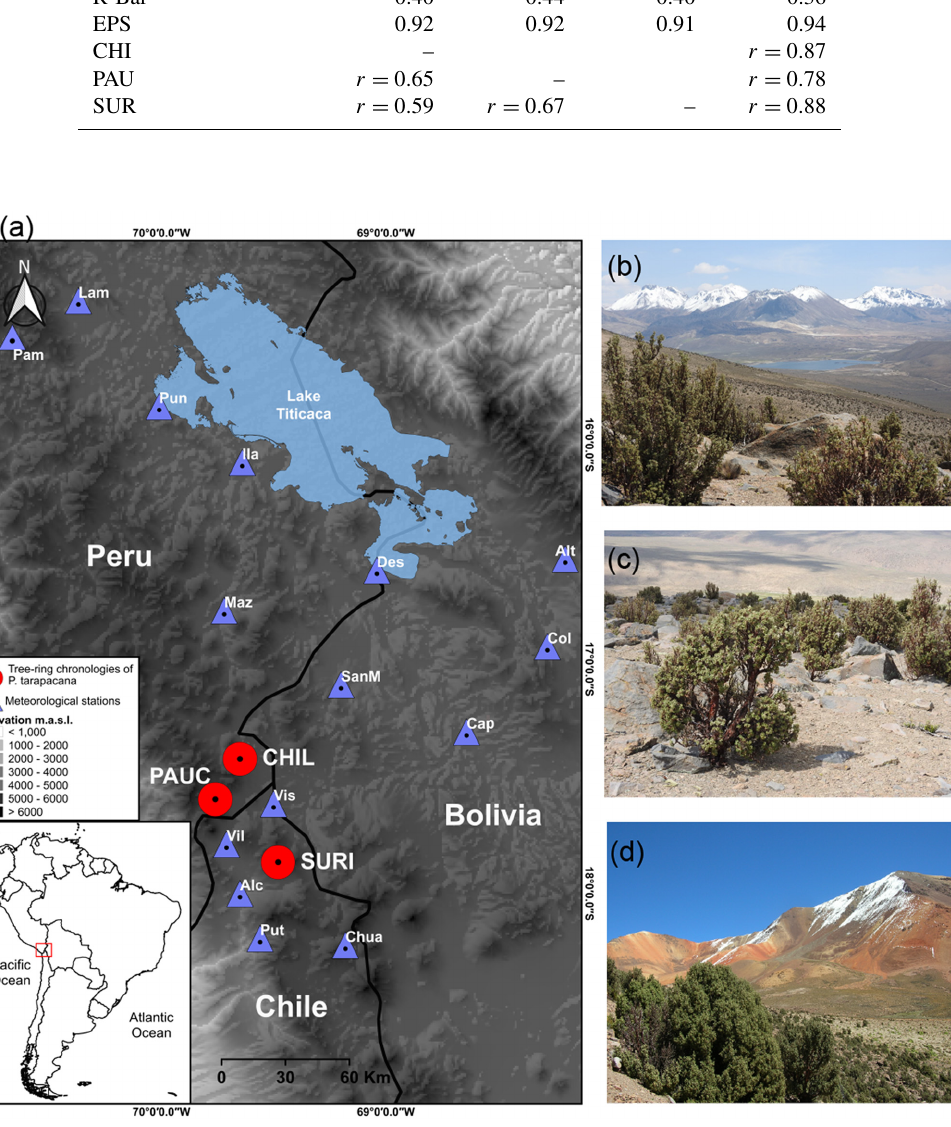
Figure 1. Study area. (a) Map of the northern Altiplano region showing the geographic locations of the three Polylepis tarapacana ring-width chronologies (red circles) and the 15 weather stations (blue triangles) used in this study to create the regional precipitation and